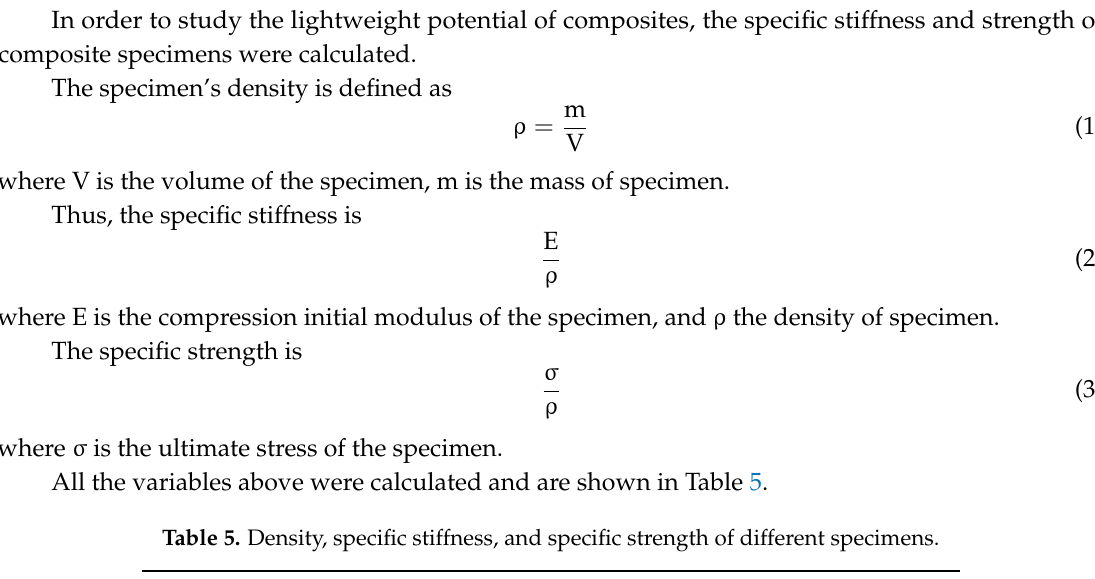
Table 5. Density, specific stiffness, and specific strength of different specimens.